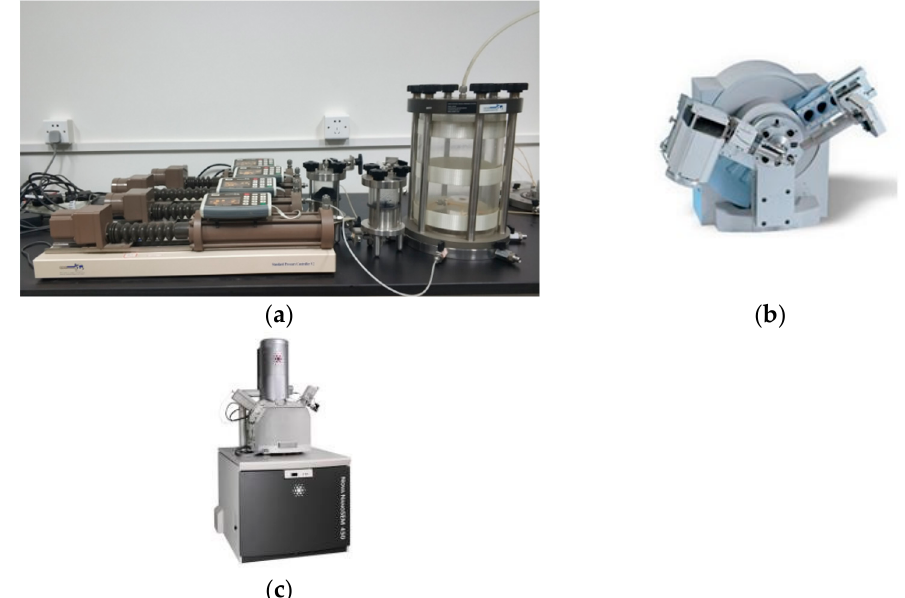
Figure 3. Permeation experiment-related instruments. ( a ) GDS; ( b ) XRD; ( c ) SEM.